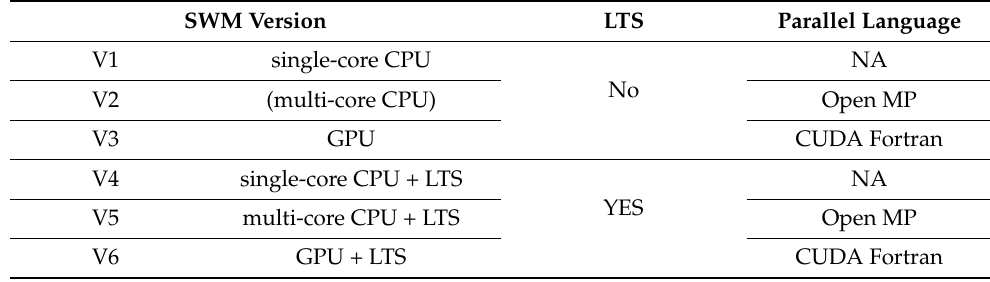
Figure 2. Numerical structures of these six versions: ( a ) single-core CPU and multi-core CPU; ( b ) GPU; ( c ) single-core CPU + LTS, and multi-core CPU + LTS; ( d ) GPU + LTS. Table 1. Summary of the six SWM versions.